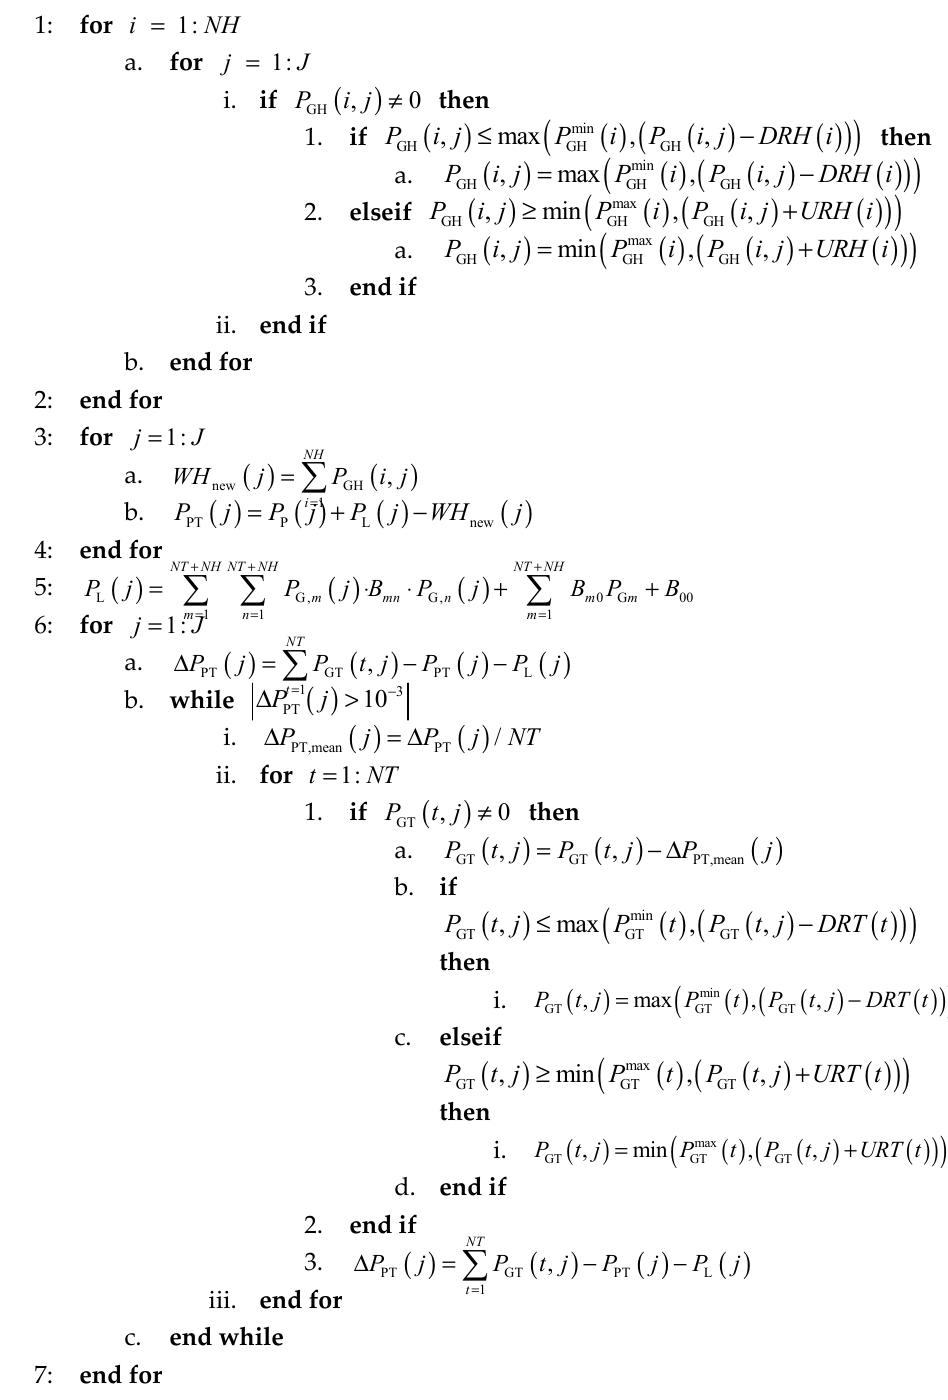
Algorithm 3: New constraints handling for real power balance and ramp rate.